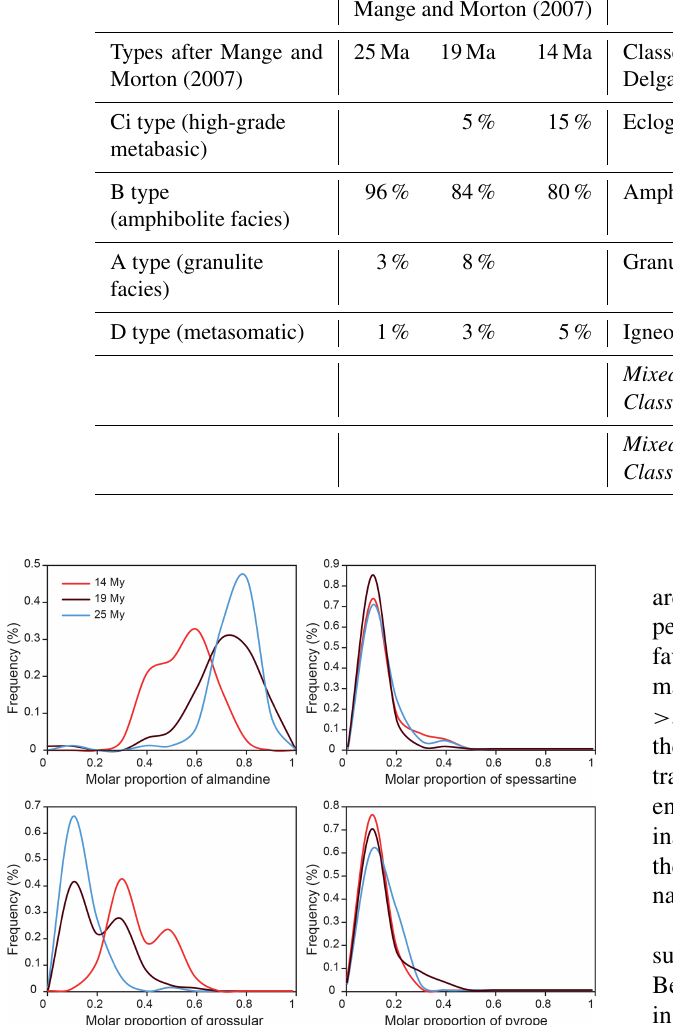
Table 4. Results from classification following Mange and Morton (2007) and Tolosana-Delgado et al. (2018). Using the linear discriminant method of Tolosana-Delgado et al. (2018), garnet was attributed to one single class if the probability for that class was ≥ 50%. Several grains were assigned mixed probabilities with < 50% per class; these are listed separately below (italic numbers). Mange and Morton (2007) Tolosana-Delgado et al. (2018)